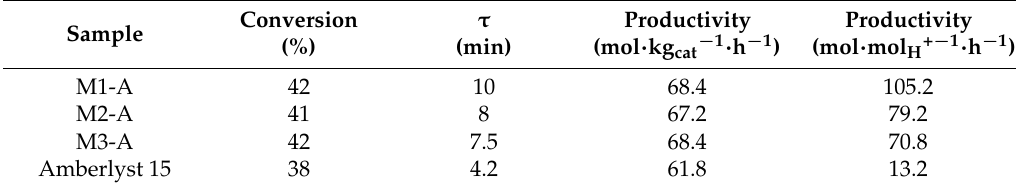
Table 3. Results from catalytic experiments.